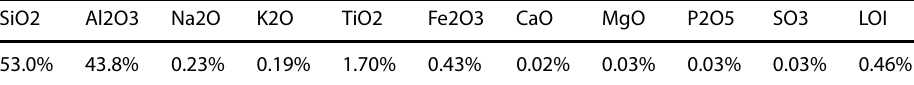
Table 1 Chemical oxide composition of BASF metakaolin